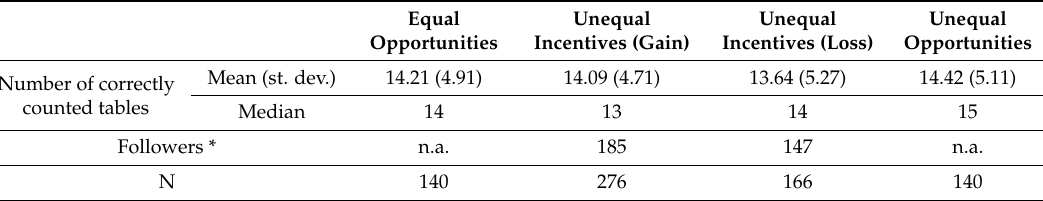
Table 2. Average performance and incentive impact across the treatments.